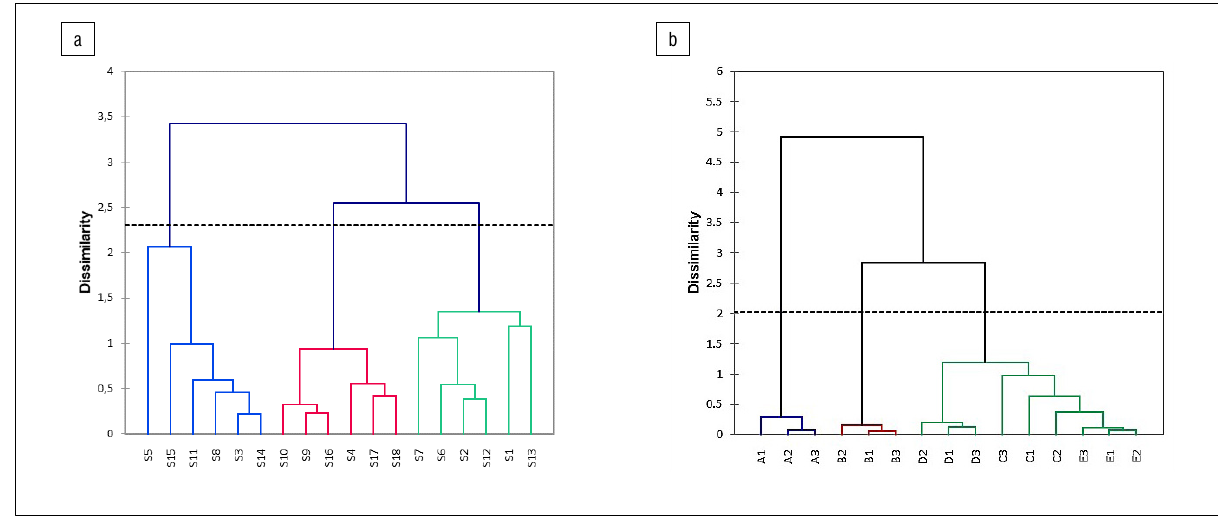
Figure 3: Dendrograms of (a) blind simulated nyaope samples and (b) casework samples analysed by hierarchical cluster analysis using unweighted linkage and Euclidean distance for the time interval t=72 h. Pearson correlation matrices for the simulated and casework samples Simulated